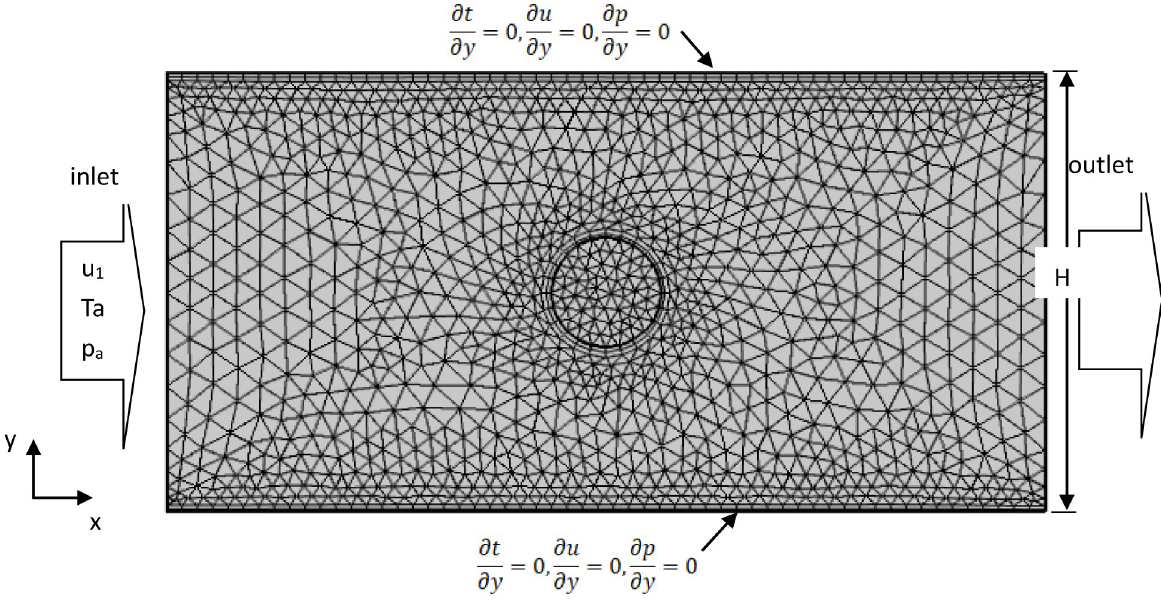
Fig 6. The overall grid schematic of the coupled flow and convective heat transfer model.